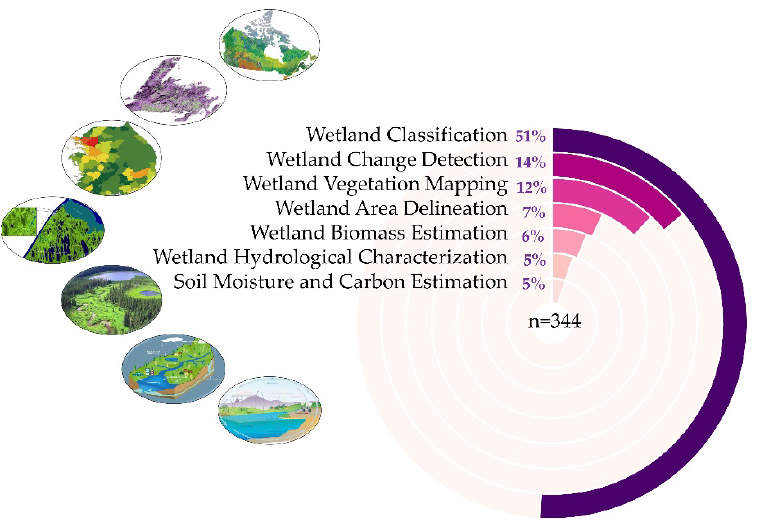
Figure 9. Overview of the diversity of application domains of RS Earth observations in wetland